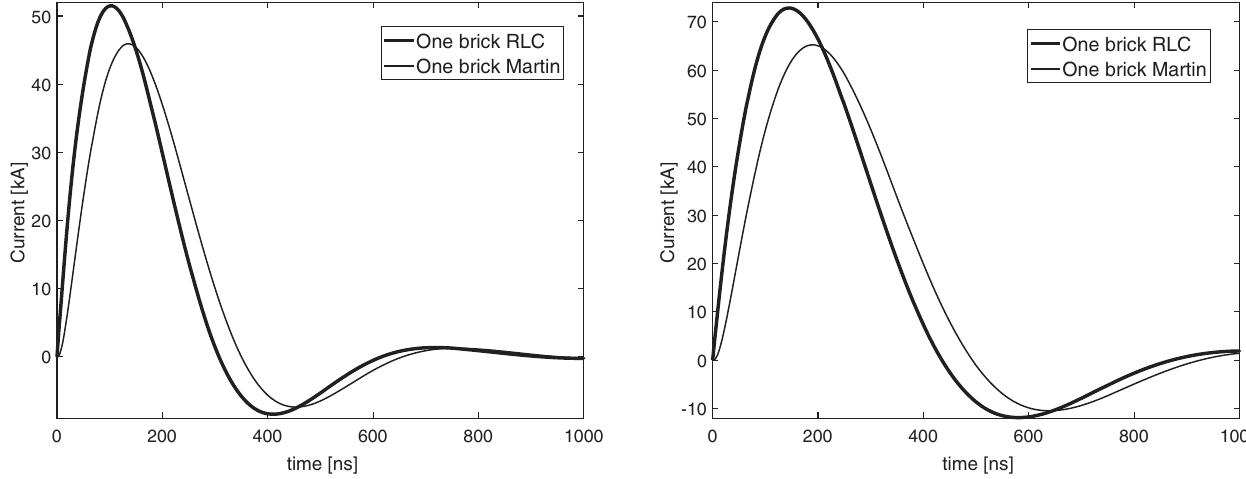
FIG. 4. Simulated output currents into a matched load for a standard brick (left) and a dry brick (right). The thick line is for the static switch model, and the thin line is for the Martin switch model.